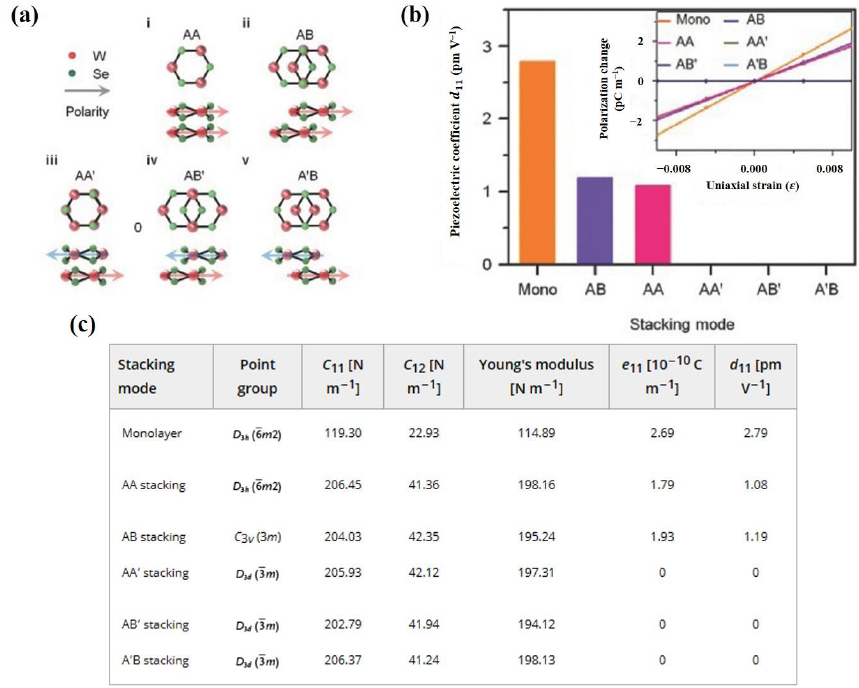
Figure 7. ( a ) Stacking structure for bilayer-WSe 2 [72]. Signs i–v correspond to AA, AB, AA’, AB’